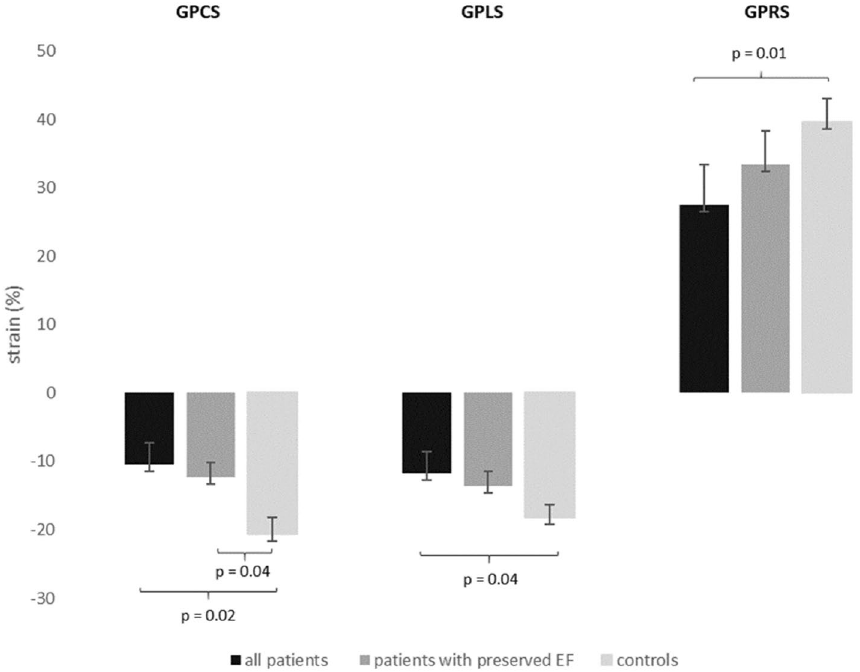
Figure 2. Global strain values in all patients, patients with preserved EF (LVEF > 50%) and healthy controls. Brackets signalize significantly different strain values between groups. (LV)EF (left ventricular) ejection fraction, GPCS global peak circumferential strain, GPLS global peak longitudinal strain, GPRS global peak radial